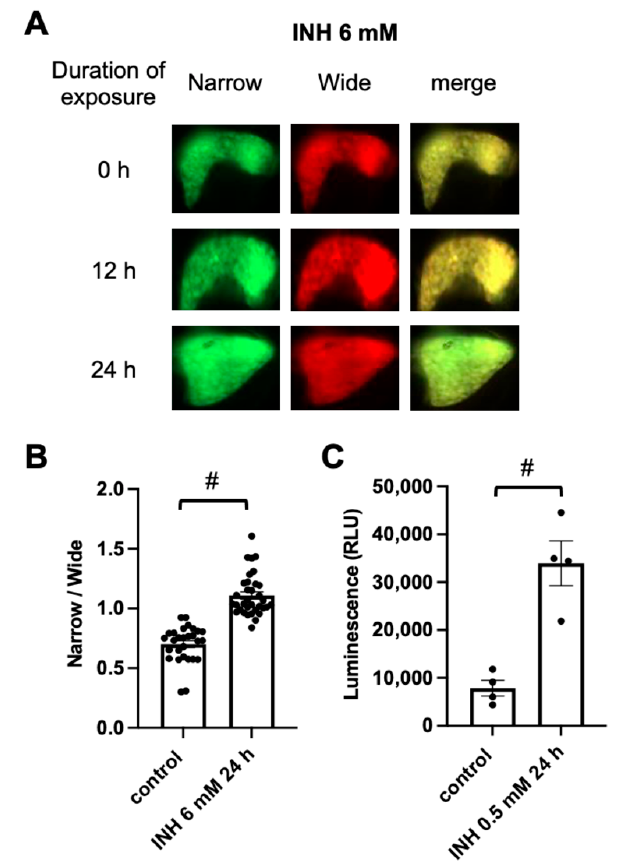
Figure 2. Assessment of hepatic apoptosis in INH-treated Tg (pck1:Casper3GR). ( A ) Representative in vivo fluorescence images of Tg (pck1:Casper3GR) treated with INH at 4 dpf. Images acquired using a narrow and wide filter and merged images are shown. ( B ) Hepatic apoptosis was assessed